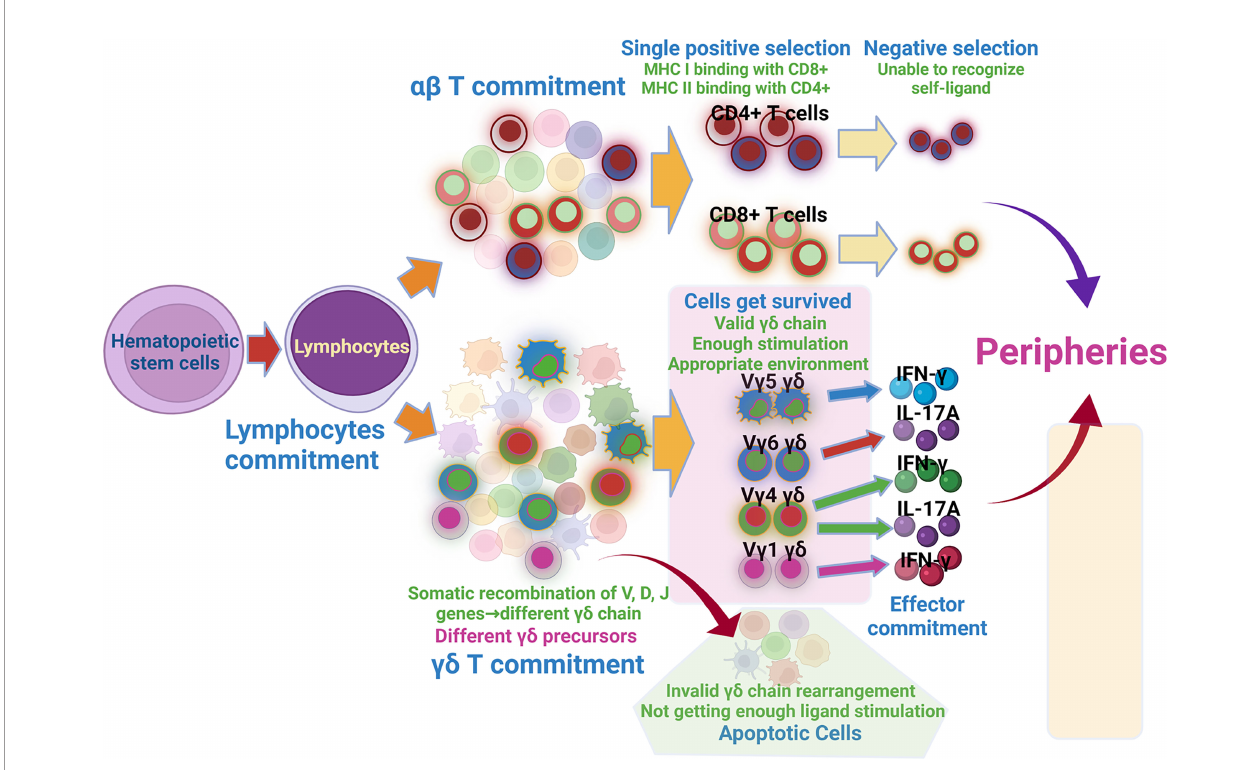
FIGURE 1 | Development of ab and gd T cells. Hematopoietic stem cells migrating into thymus get lymphocytes commitment, the lymphocytes then get ab commitment and gd commitment. ab cells passing through sequential single positive selection and negative selection get matured. Somatic recombination of V, D, J genes forms different gd chain, which produces varied gd precursors. Among them, cells with valid gd chain, getting enough stimulation and appropriate environment get survived, cells with invalid gd chain and getting insuf fi cient ligand stimulation get apoptosis. Survived gd T cells then undertake effector commitment and get